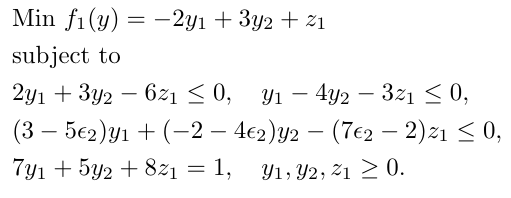
Table 2. Solution of problem P ∗